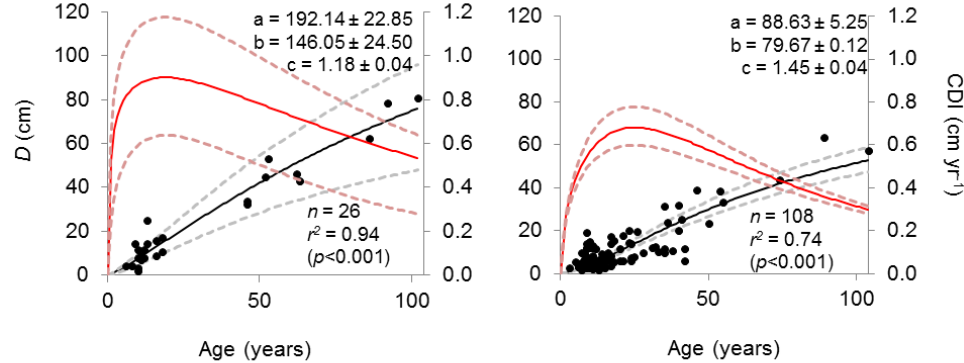
Fig. 3. Significant age-diameter relationships for V. divergens and other tree species. The red line indicates the annual current diameter increment (CDI). Indicated parameters are for the age-diameter relationship of Eq. (9). Standard deviation is indicated by the dotted lines.